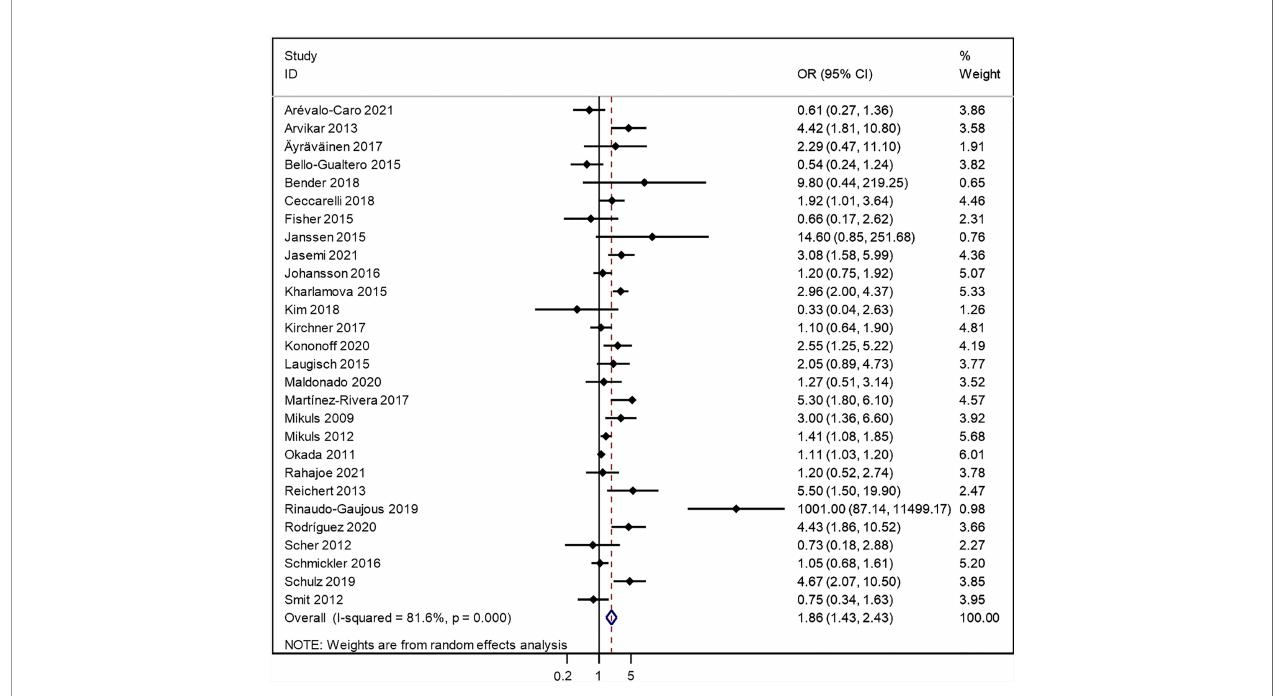
FIGURE 2 | Forest plot for the association between porphyromonas gingivalis ( P. gingivalis ) and rheumatoid arthritis (RA) of dichotomous data.